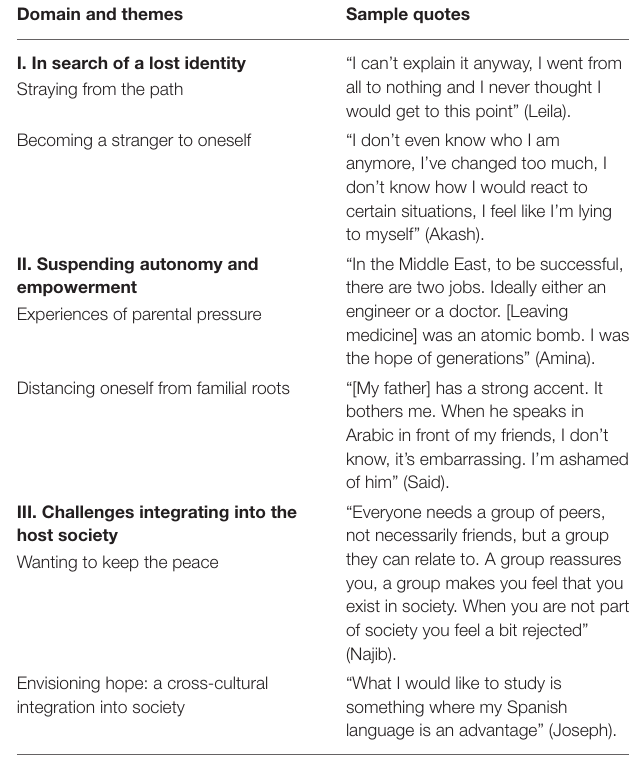
TABLE 2 | Domains, themes and sample